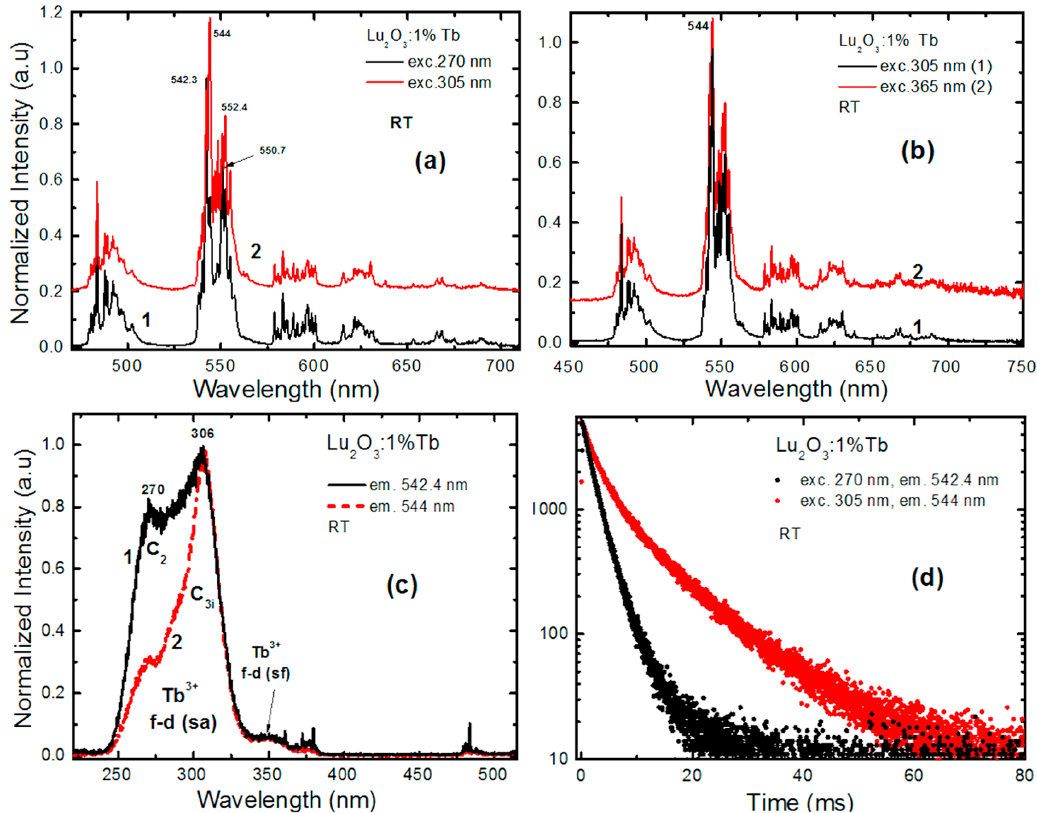
Figure 9. PL emission ( a , b ) and excitation spectra ( c ) as well as the PL decay kinetic ( d ) of Tb 3+ luminescence in Lu 2 O 3 :Tb NP at 300 K.